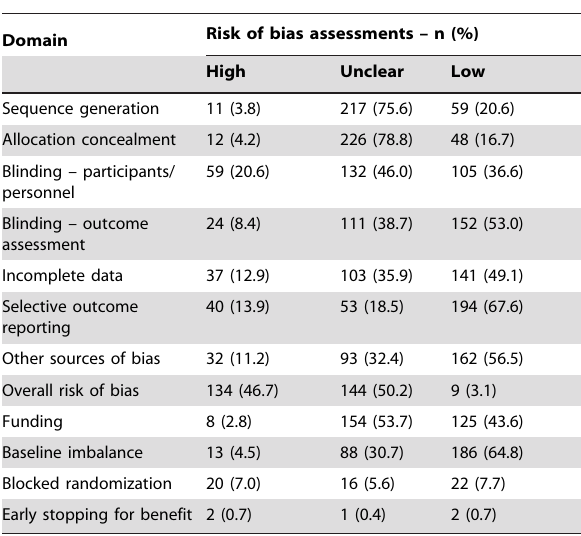
Table 2. Risk of bias assessments by domain (N=